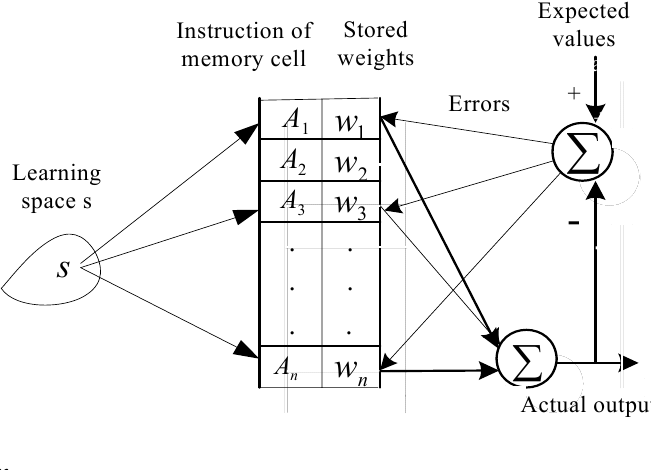
Figure 1. Basic structure diagram of a